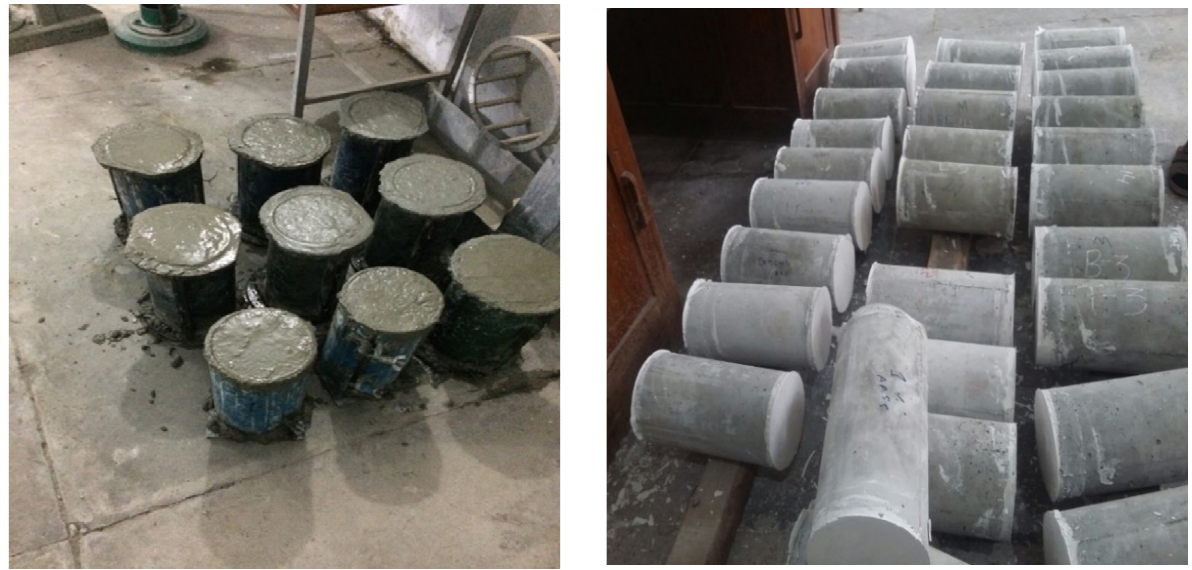
Figure 4. Cylindrical specimen of plain cement concrete and fibers reinforced concrete.